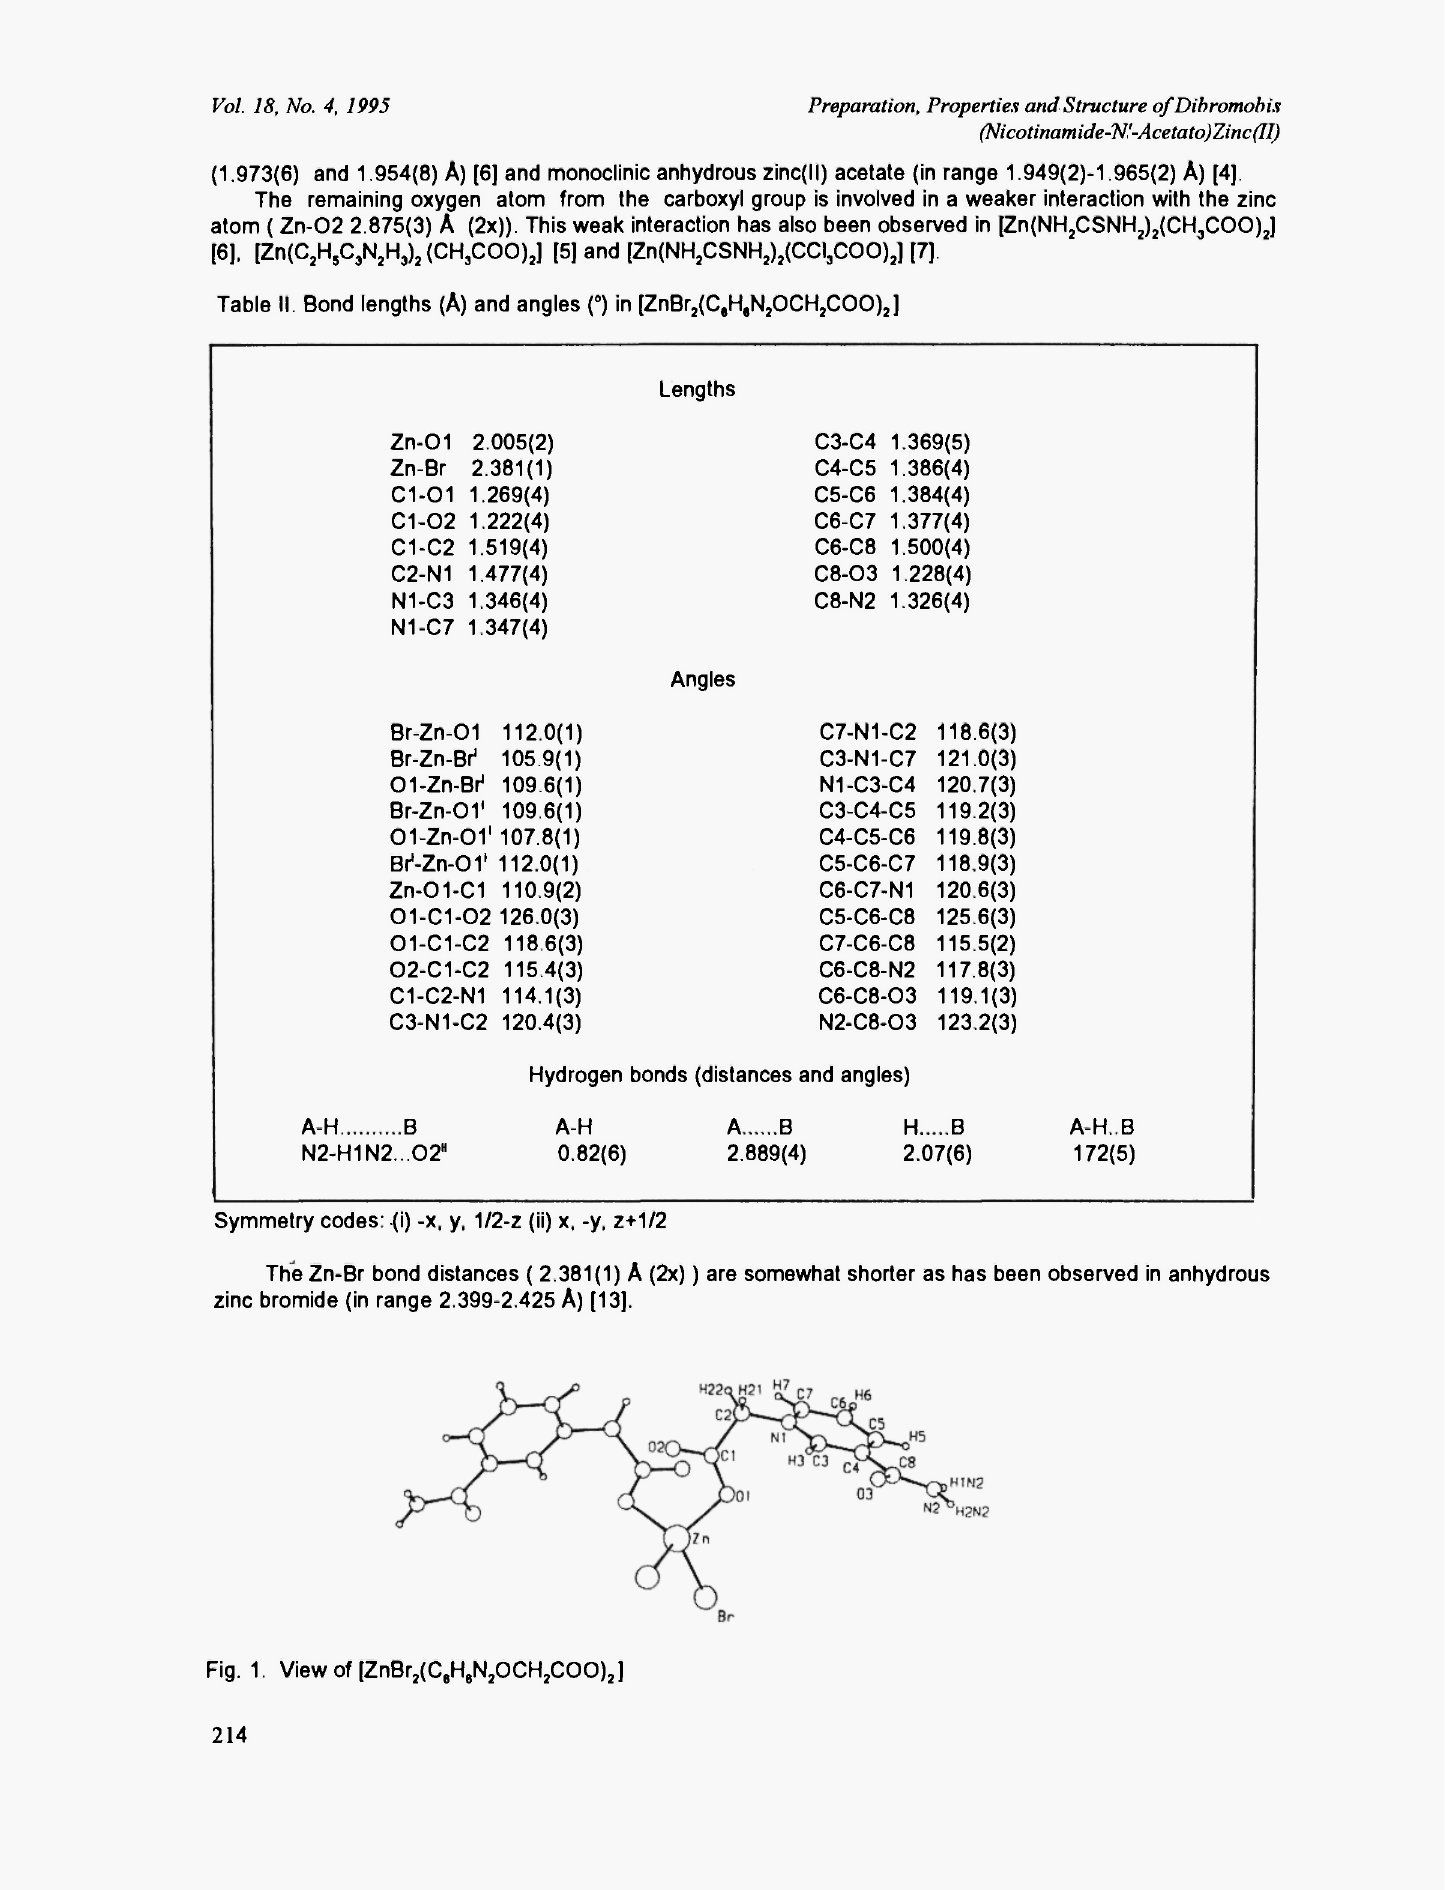
Fig. 1. View of [ZnBr 2 (C e H e N 2 OCH 2 COO) 2